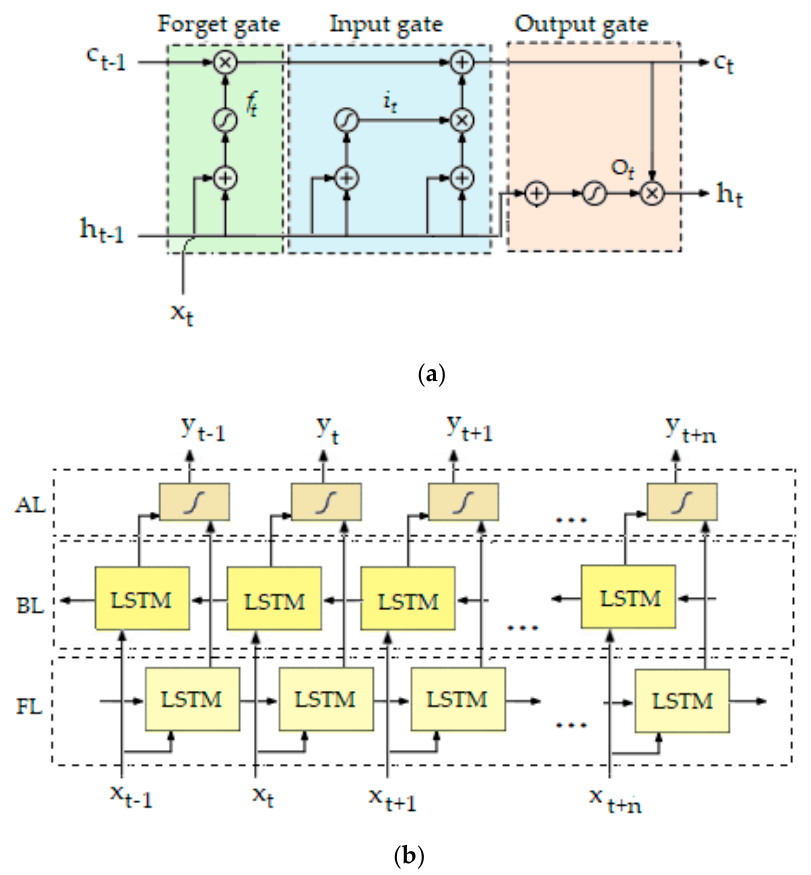
Figure 3. ( a ) Diagram of long short-term memory (LSTM) cell consisting of forget gate (f t ), input gate (i t ), and output gate (o t ) which control the activation of the cell (c t ) and the output of the cell (h t ); ( b ) bidirectional LSTM. FL—forward layer, BL—backward layer, AL—activation